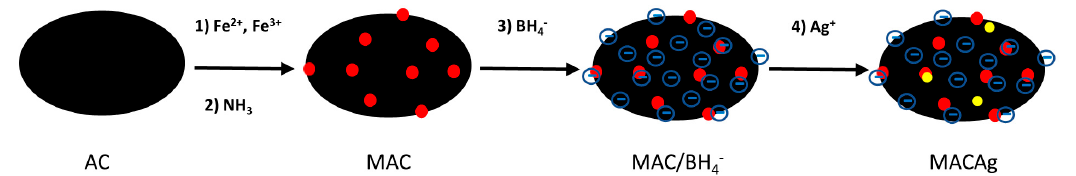
Figure 1. Schematic representation for preparing MACAg nanocomposite. AC = activated carbon; MAC = magnetite-activated carbon nanocomposite; BH 4 − = borohydride; MACAg = magnetite-activated carbon-silver nanocomposite.